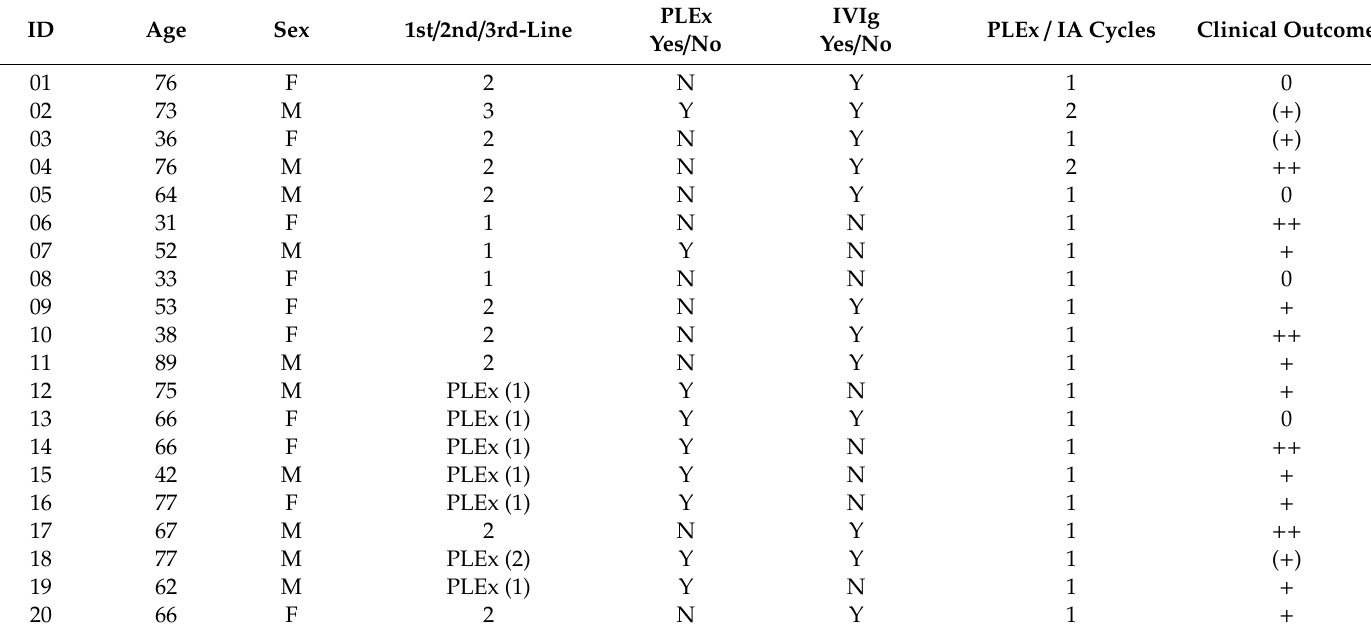
Table A2. Baseline characteristics and response to IA treatment of the GBS